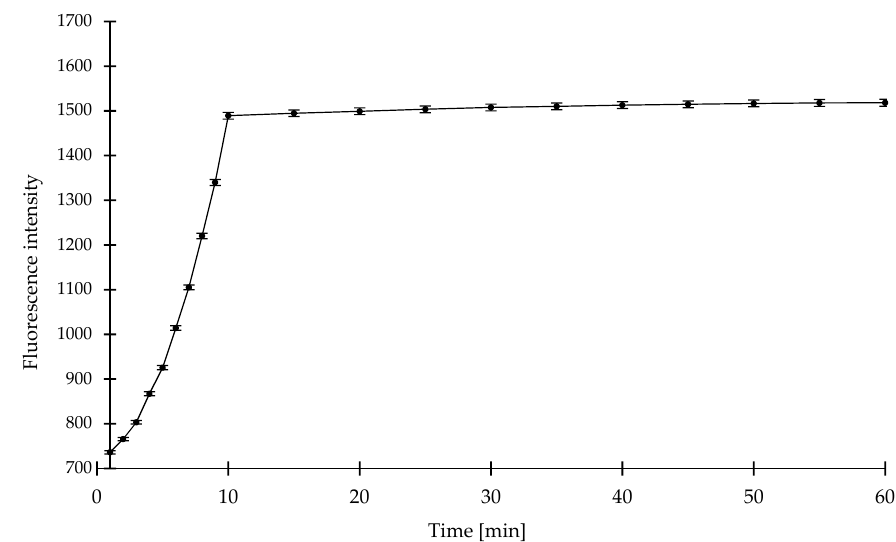
Figure 9. Time course experiment of the compound 1 (0.1 mM) reacting with NaHS (0.1 mM) in sodium phosphate buffer (pH = 7.4) at room temperature. Time points represent time range from 1 to 60 min after addition of NaHS (0.1 mM). Means ± SE from three measurements of the fluorescence responses are presented.